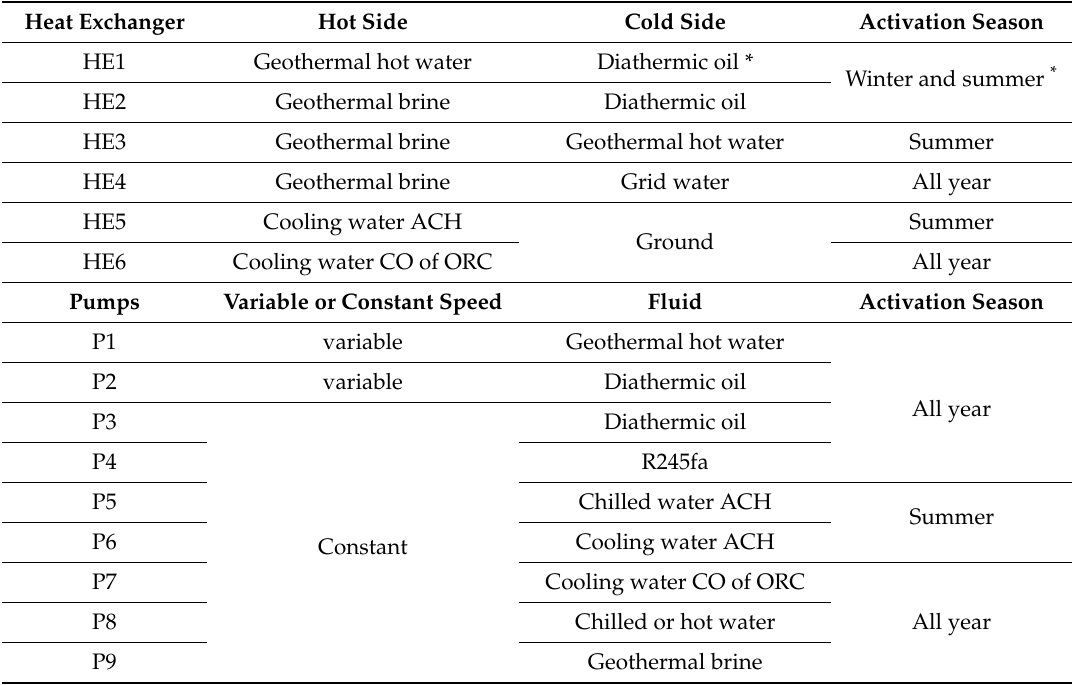
Table 1. Heat exchangers and